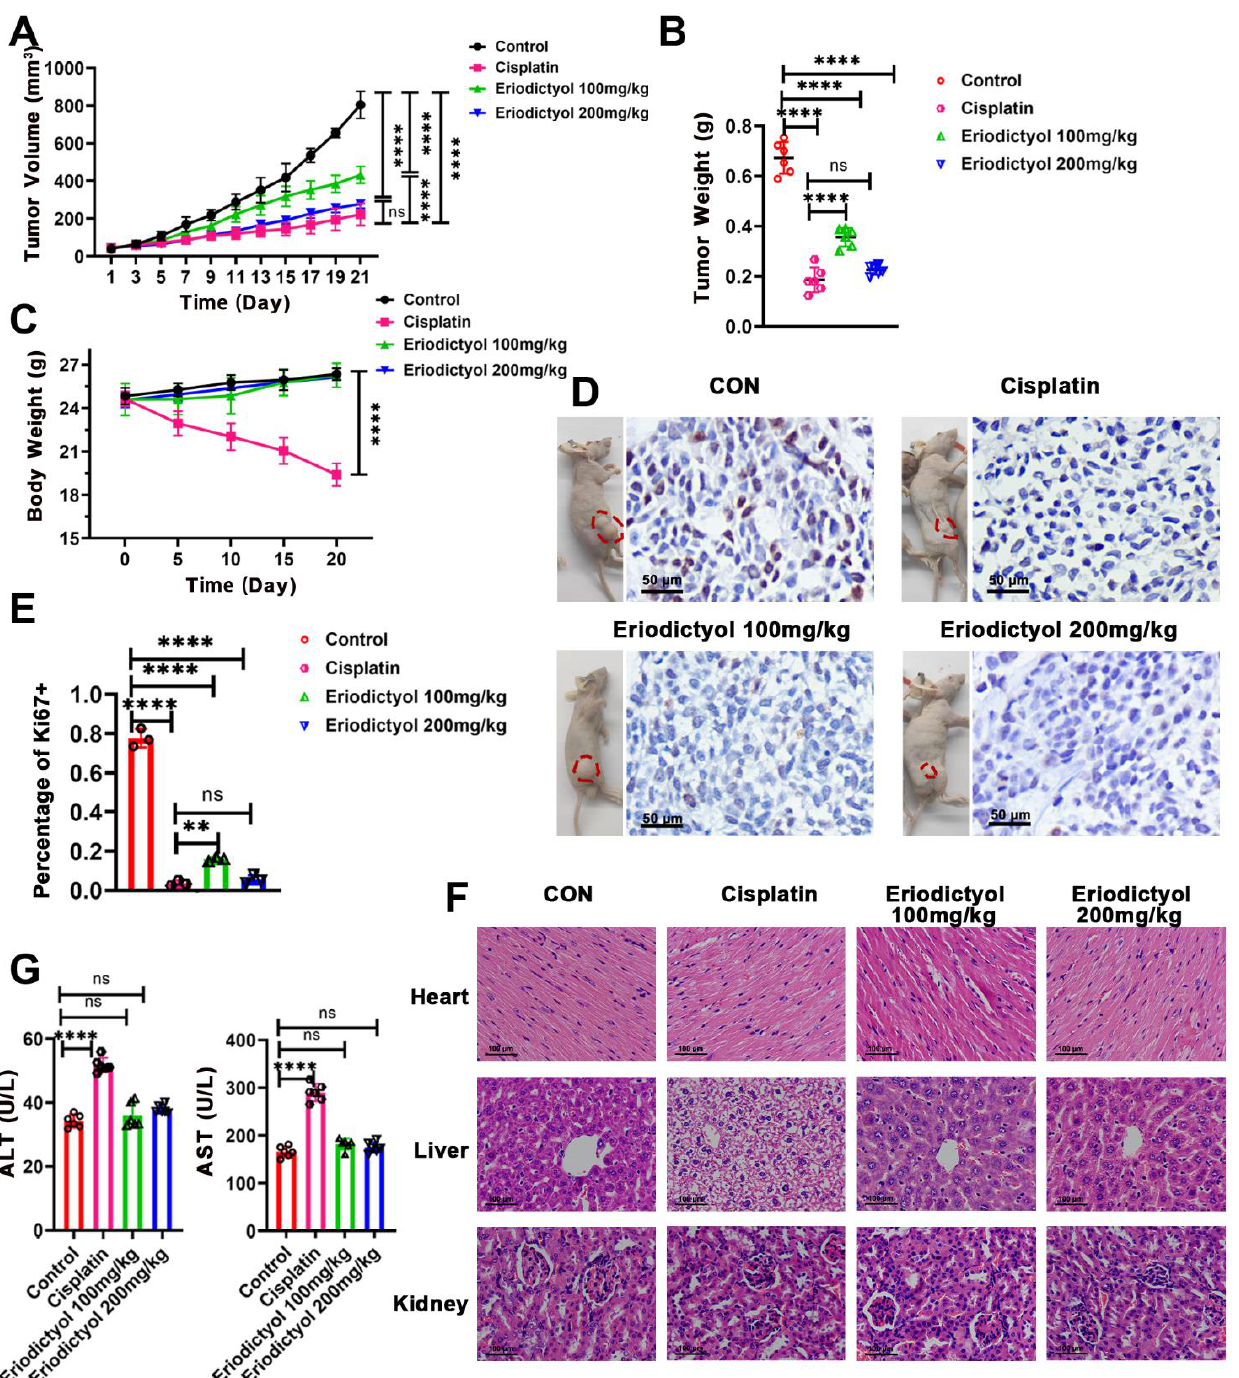
Figure 4. Eriodictyol inhibits tumor growth in vivo. ( A – C ) The tumor volumes ( A ), tumor weights ( B ), and body weights ( C ) of the mice from control, cisplatin-treated, and eriodictyol-treated groups were measured, and the statistical results are shown ( n = 6). ( D ) The representative images of mice bearing tumors and the Ki-67 staining results of the corresponding tumors are shown. Original magnification, 400×; scale bars, 50 µm. ( E ) The quantitative analysis of Ki-67-positive percentages is demonstrated as a histogram. ( F ) H&E staining of major organs from each group. Original magnification, 400×; scale bars, 100 µm. ( G ) Serum levels of ALT and AST were detected and are statistically illustrated as a histogram ( n = 6). Data are presented as mean ± SD. ns: no significance, ** p < 0.01, **** p < 0.0001.